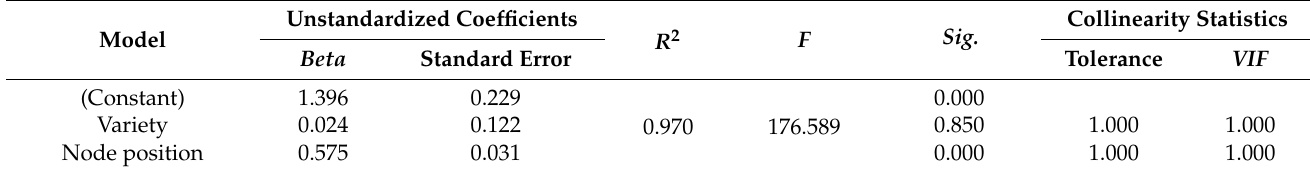
Table 5. Table of regression coefficients of the weight of banana